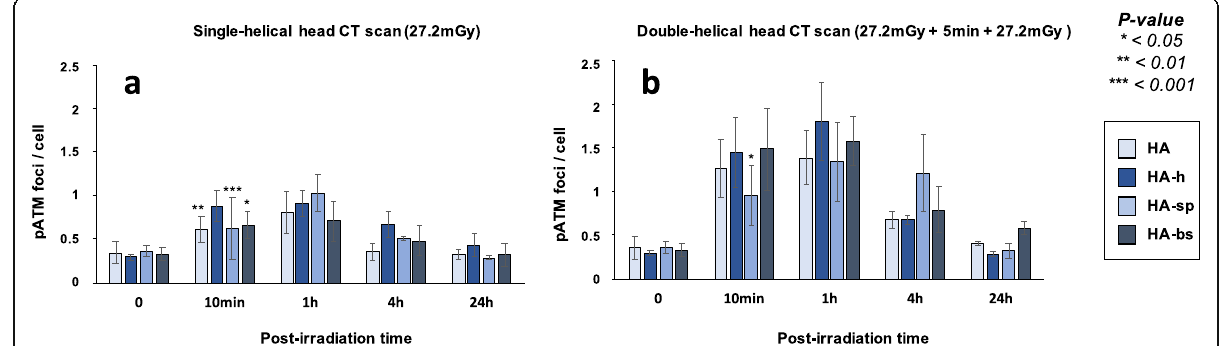
Fig. 8 pATM foci in astrocytes after single and double-helical CT-scan exposure. a Kinetics of pATM foci in astrocytes after a single helical head CT scan, or ( b ) a double-helical head CT scan at the indicated times after exposure (t0 = non-irradiated). Each data represents the mean ± SEM foci per cell of three independent experiments. Asterisks for time 10 min correspond to a statistically significant difference between HA-h and the other cell lines. CT Computed tomography, γ H2AX Phosphorylated forms of the H2AX histone variant, pATM Phosphorylated forms of the ATM protein, SEM Standard error of the